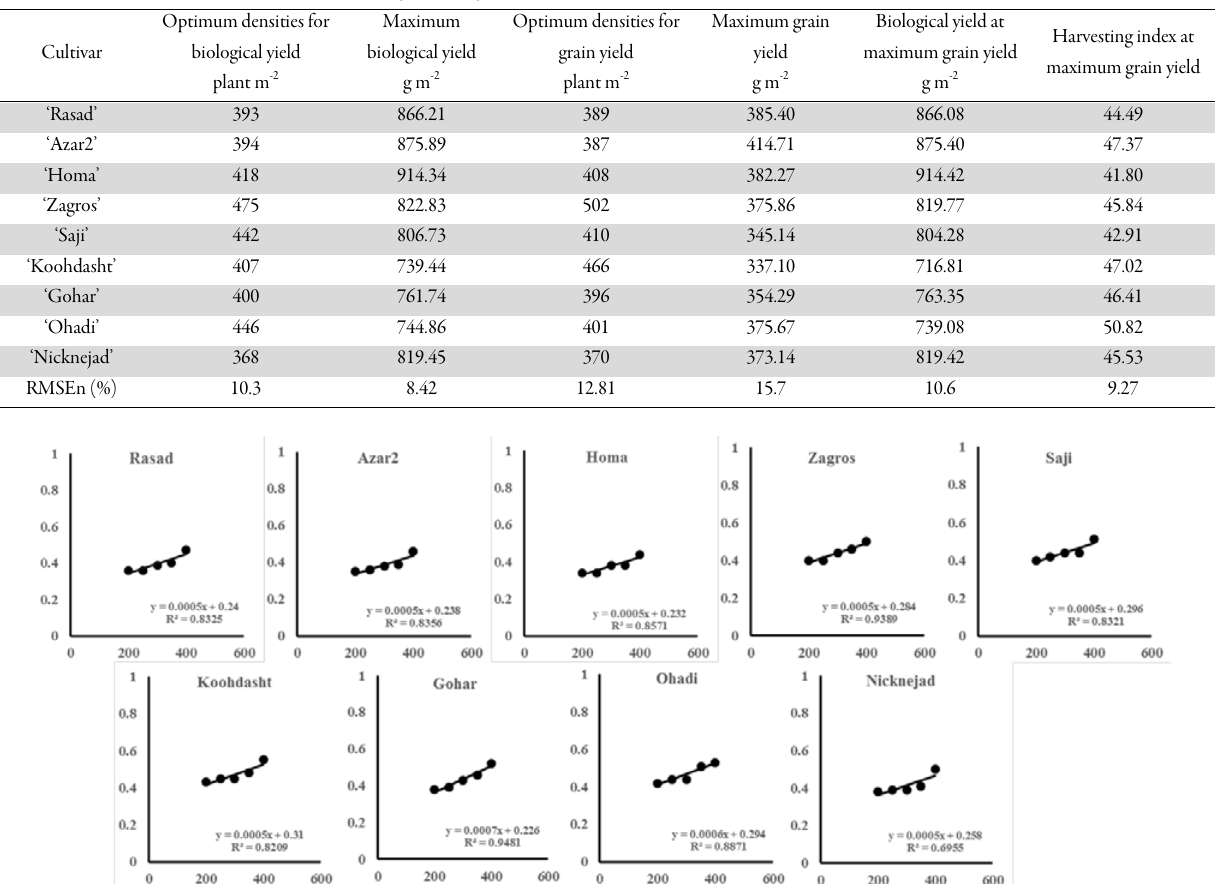
Fig. 1. Relations between the reciprocal of biological yield per plant and plant density. X axis: Plant population (plant m -2 ); Y axis: 1/w